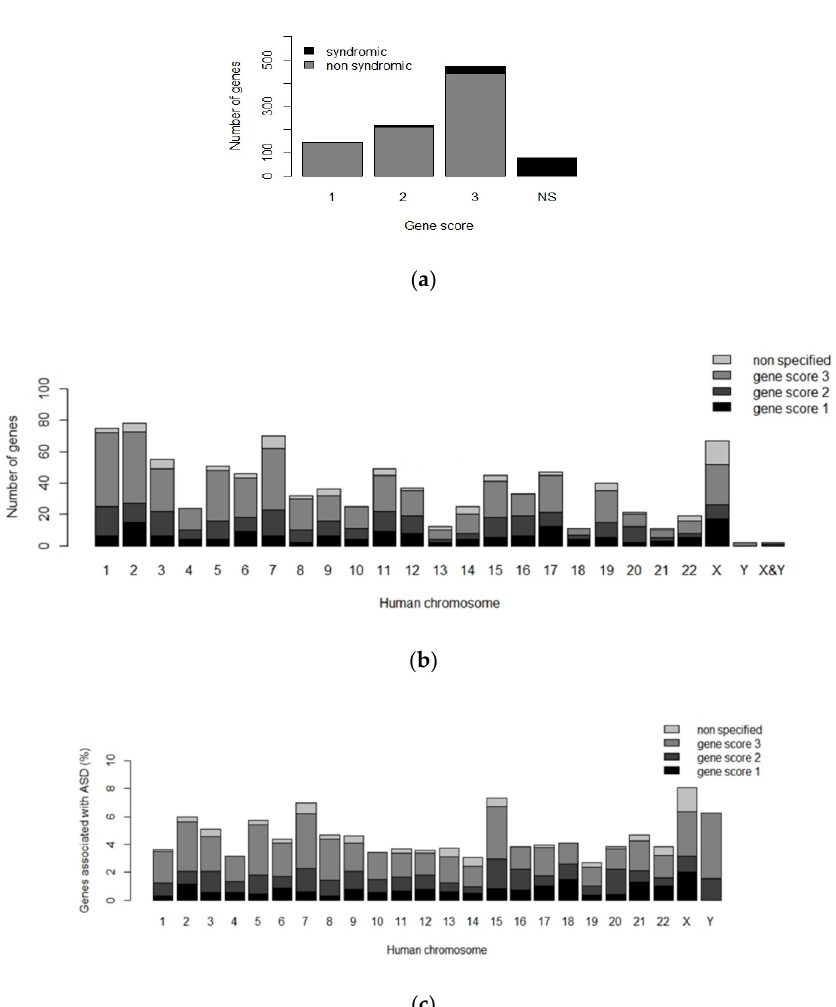
Figure 2. Human ASD-associated genes according to the SFARI Gene Database (2020). Gene score 1: high confidence genes with a minimum of three de novo likely gene disrupting mutations associated to ASD. Gene score 2: strong candidate genes with two de novo gene-disrupting mutations associated to ASD. Gene score 3: suggestive evidence of the association of the gene with ASD development, due to one reported de novo likely gene-disrupting mutation. ( a ) Classification of the 913 ASD-associated genes in the SFARI Gene Database according to the gene score and their presence in syndromic or non-syndromic ASD patients (NS = non-specified); ( b ) ASD-associated genes distribution in the human genome; ( c ) Percentage of ASD-associated genes identified on each human chromosome. The figure was elaborated using open-access data from SFARI Gene Database (obtained in January 2020) and R software